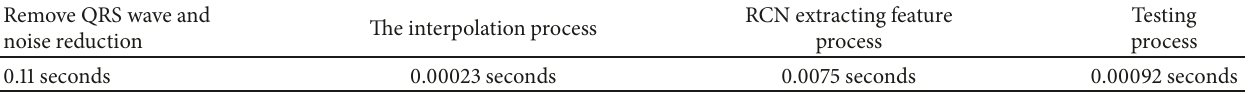
Table 6: Comparison of the time spent in each